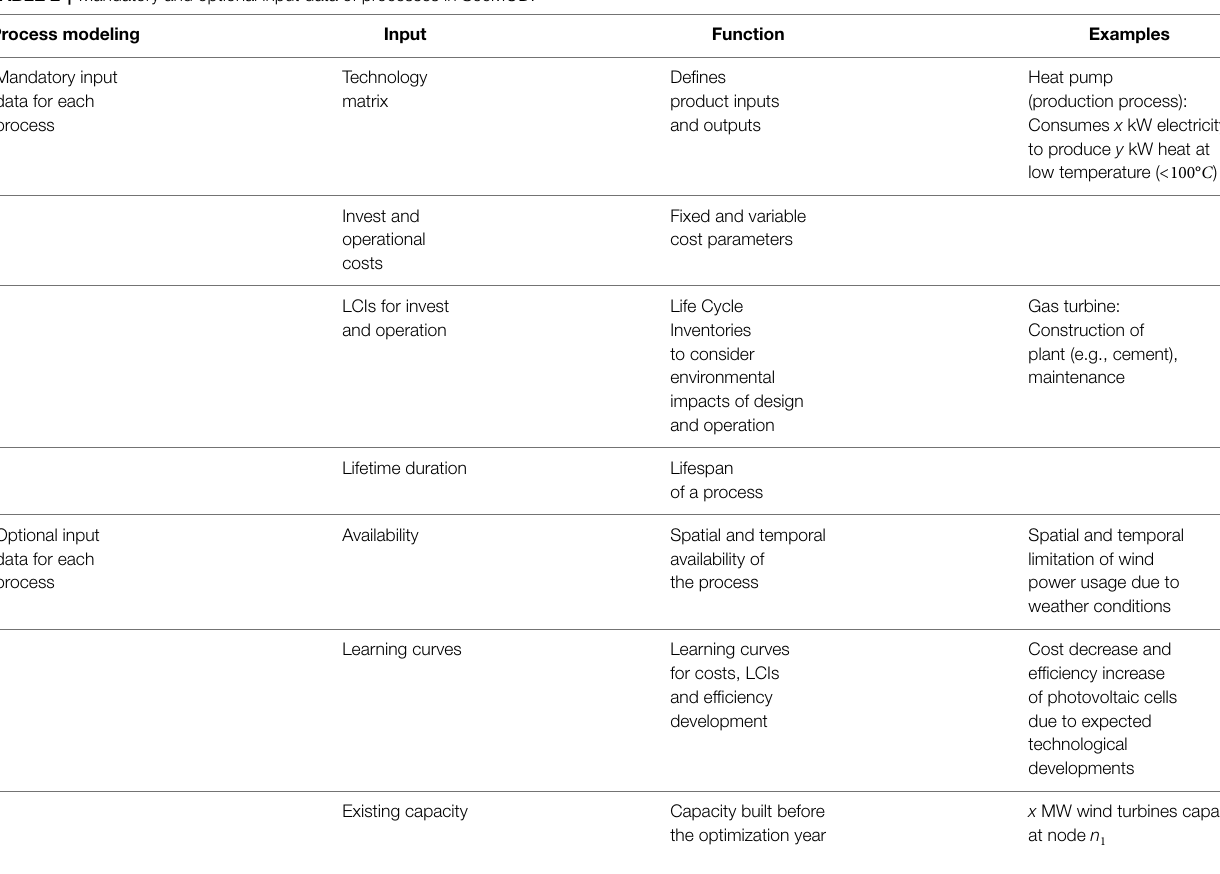
TABLE 2 | Mandatory and optional input data of processes in